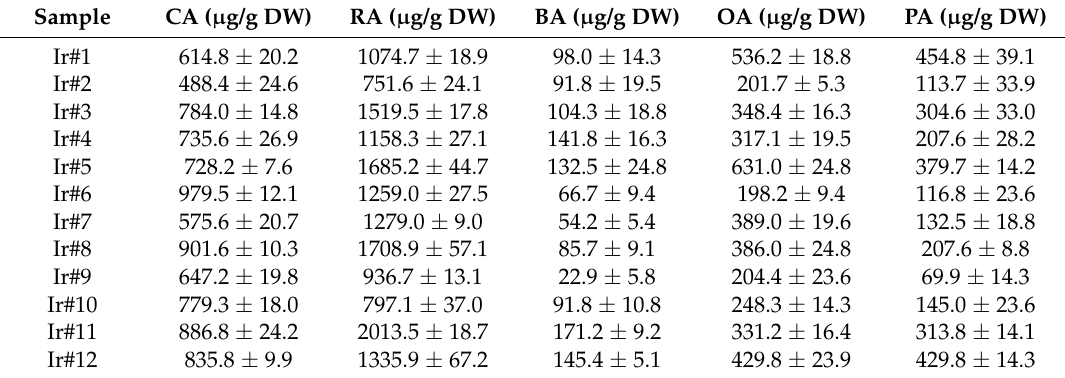
Table 2. Quantification of the main phytochemicals accumulated in twelve I. rugosus callus sample extracts (culture conditions are presented in Table